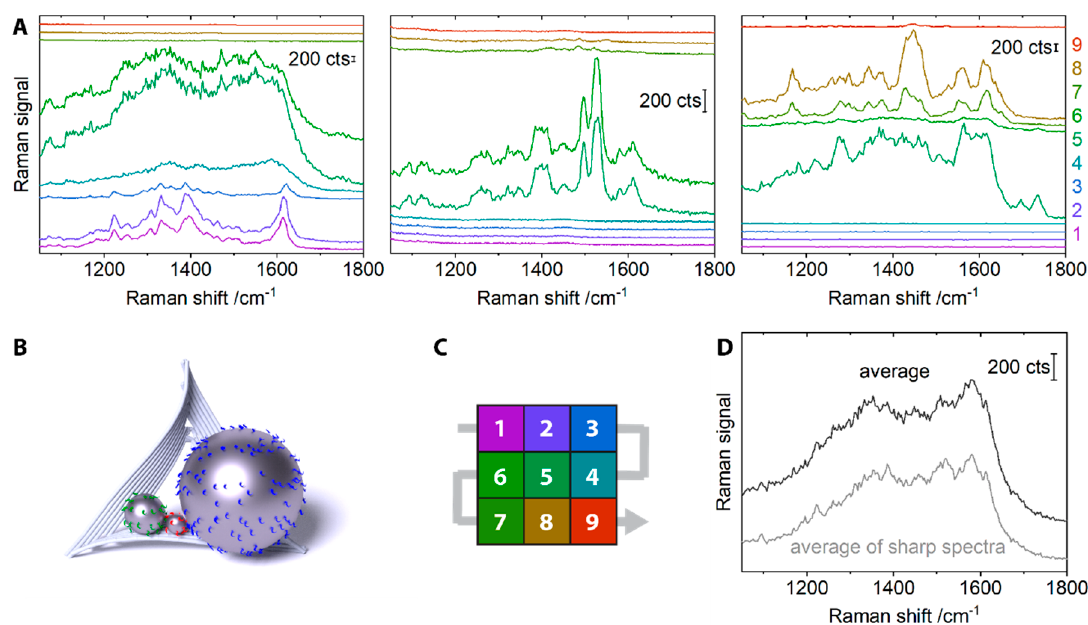
Figure 4. ( A ) Each panel shows the evolvement of the SERS spectrum of a single silver nanolens over time (532 nm illumination, 4 s, left and right: 685 kW cm − 2 , middle: 100 kW cm − 2 ). The nine spectra in each panel originate from the nine di ff erent positions during the Raman mapping around the single nanolens. Since the laser spot is larger than the raster size of the scan, each nanolens is sampled several times, thereby enabling us to create a time series from the consecutively sampled positions. ( B ) Schematic representation of a DNA origami-assembled silver nanolens. ( C ) Scan path around a single silver nanolens (located at position 5). Numbers and colors correspond to the ones in the SERS spectra under (A). ( D ) Averaged SERS spectra from the twelve single silver nanolenses irradiated at 685 kW cm − 2 . For the grey spectrum, only those spectra with distinct peaks were included. The broad double peak shape that is characteristic for amorphous carbon persists. All spectra are o ff set for